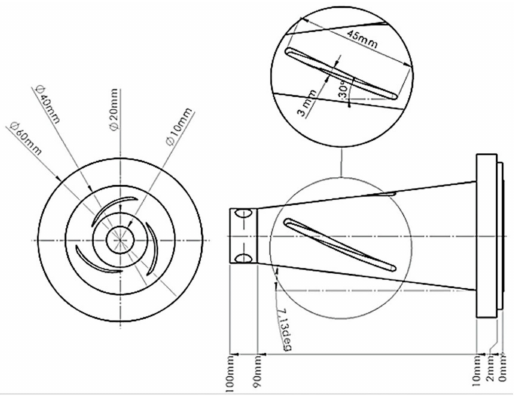
Figure 1. Horn type tool holder model design with helical slots formed on its planar surface. Table 1. Chemical composition and mechanical properties of C45 (EN 1.0503) type steel. Chemical Composition, %